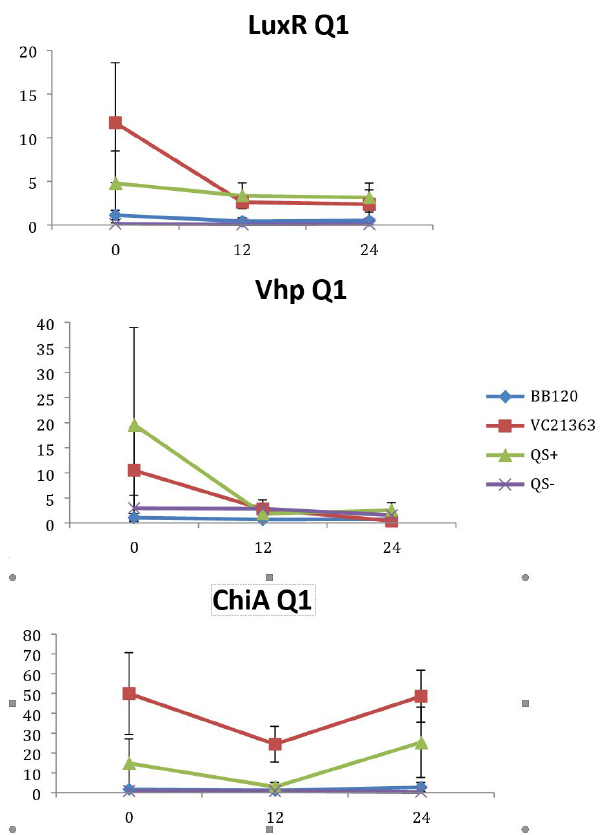
Fig. 1. Relative gene expression levels of luxR, vhp and chiA over a 24h period in treatment with 8x10 5 cells ml of Skeletonema and Vibrio 10 7 cells ml -1 . Y-axis= Relative expression to RpoA, X-axis= Time elapsed (hr). Error bars represent standard error of